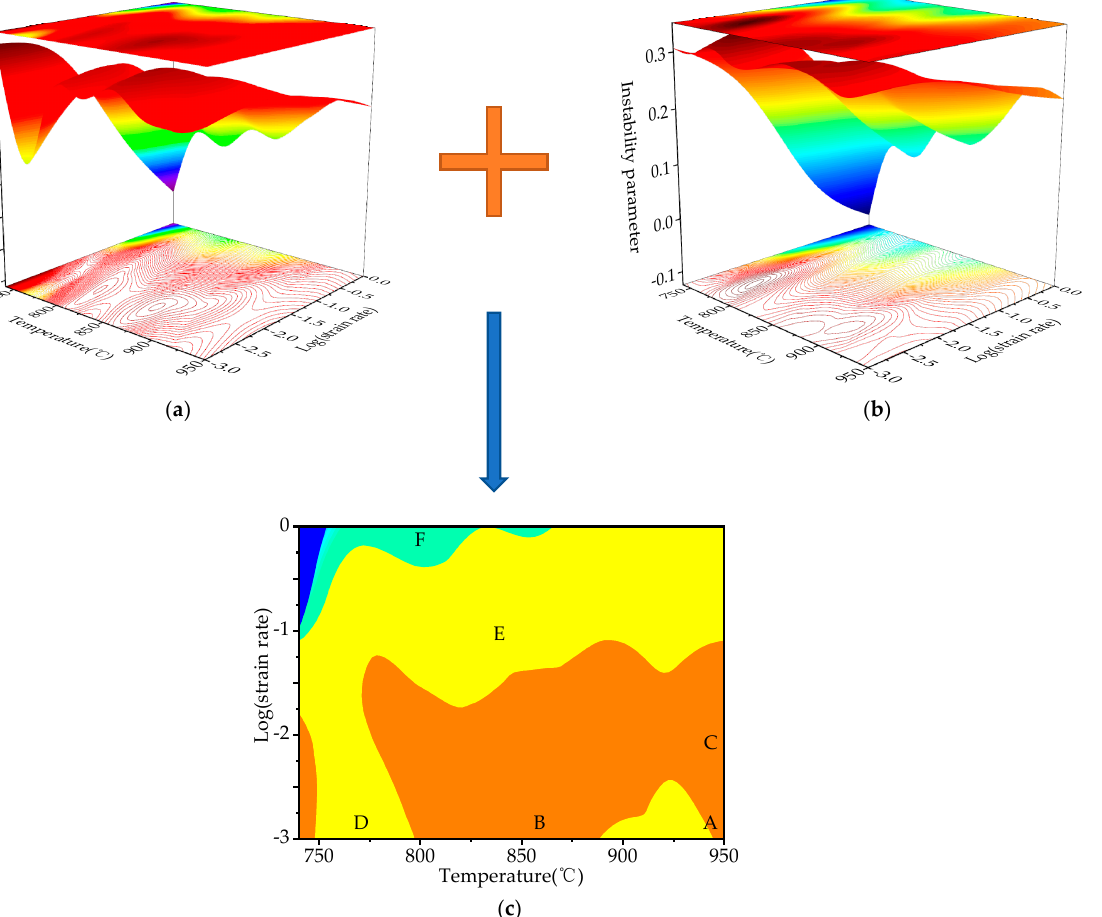
Figure 7. ( a ) Power dissipation efficiency map, ( b ) plastic flow instability map, and ( c ) hot processing map of Ti − 65541 alloy at a strain of 0.7.